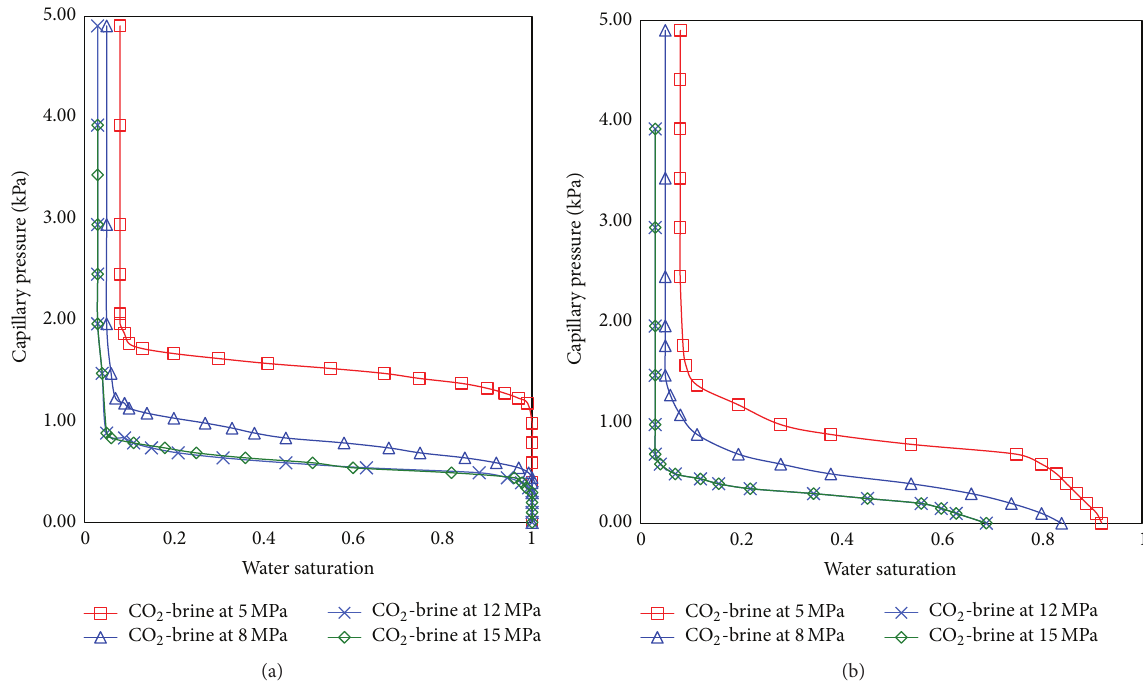
involved in the control of the capillary pressure ( 𝑃 𝑐 ) using the capillary pressure regulator. Uncertainties in average capillary pressure ( 𝑃 𝑐 ) and water saturation ( 𝑆 𝑤 ) of the sample are ∼ 10 Pa and ∼ 0.015, respectively, considering the resolution of capillary pressure regulator. In both Figures 3 and 4, the